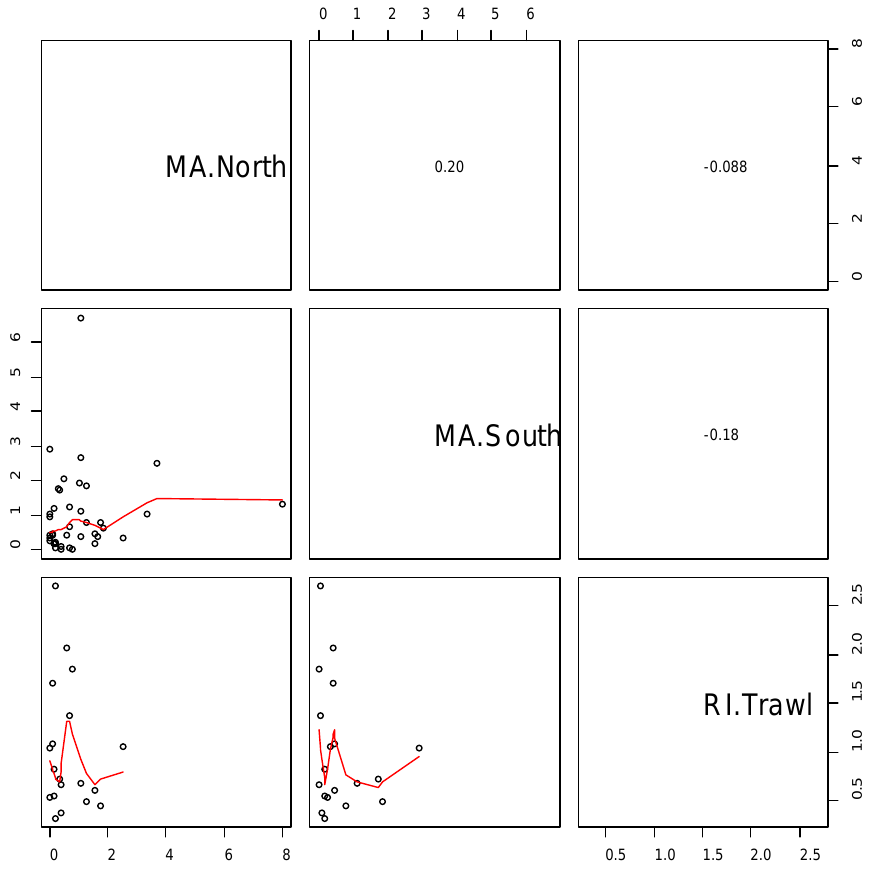
Figure 73. Correlation coefficients and scatter plots for the horseshoe crab abundance indices in the Northeast Region for 1978-2017. All correlations are insignificant ( P